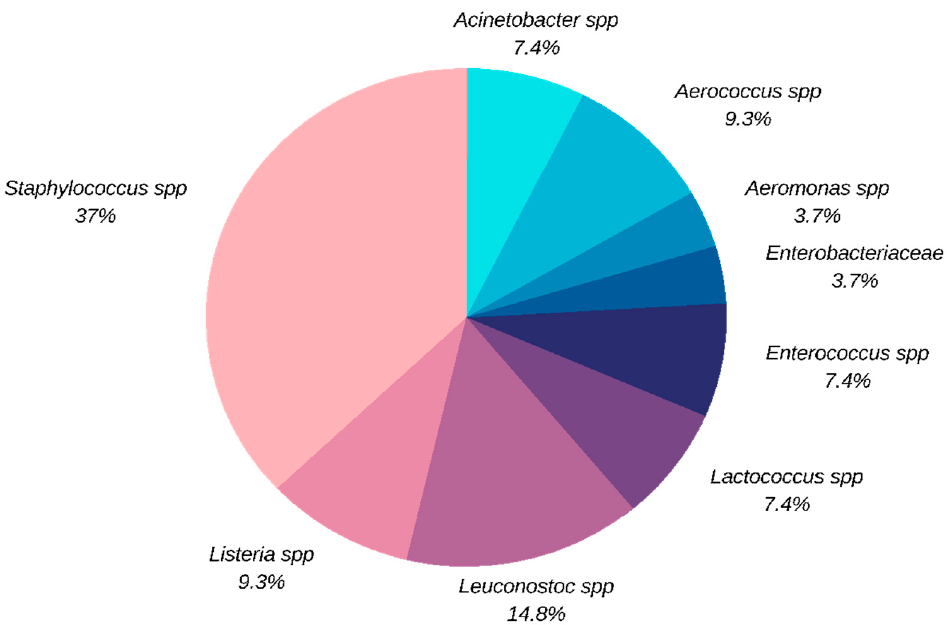
Figure 1. Bacterial species detected in the selective plates.